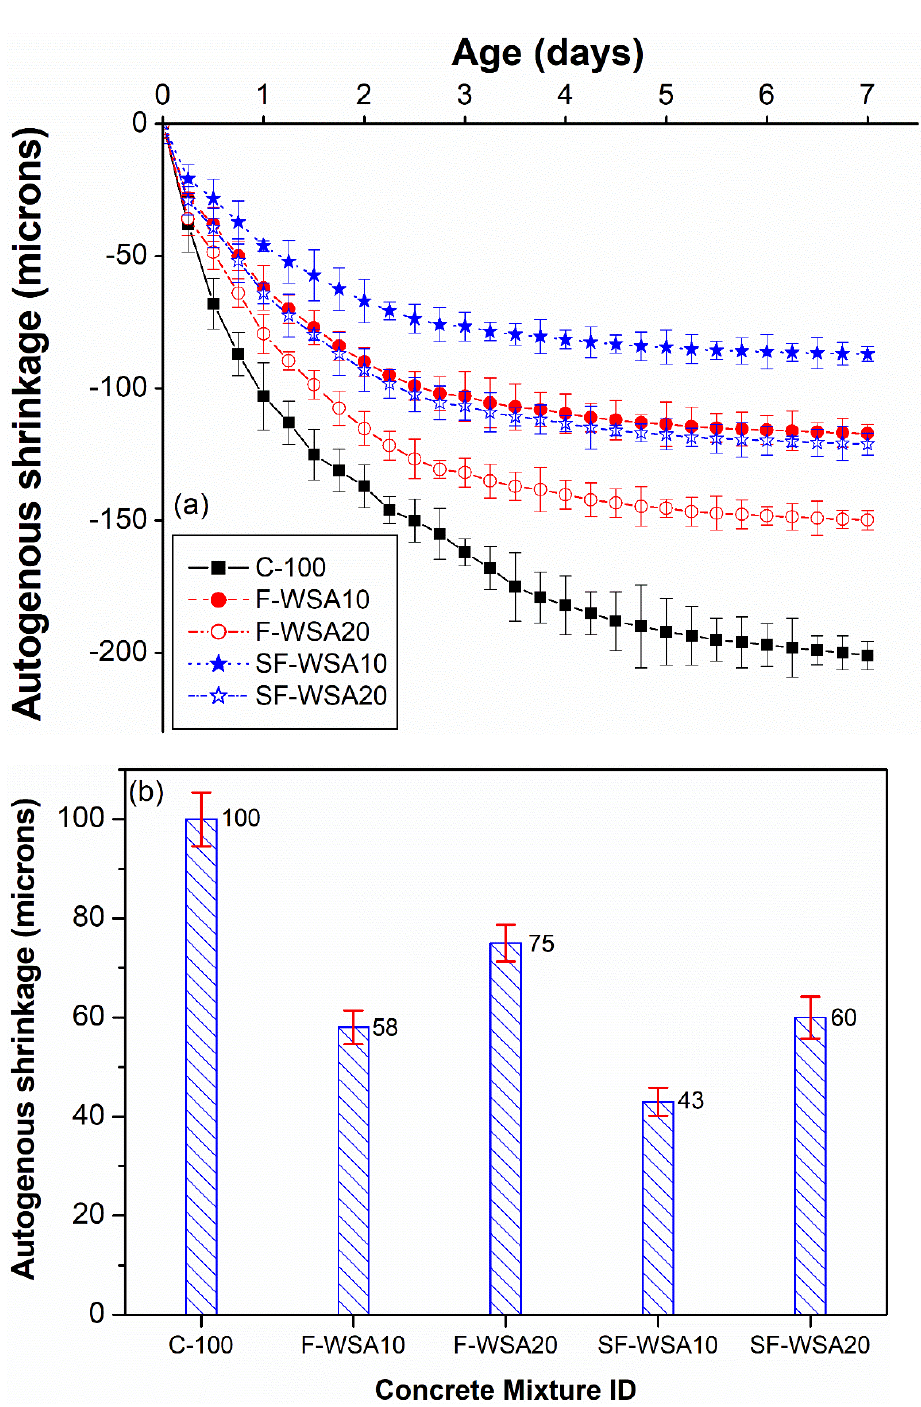
Figure 8. ( a ) Comparison of autogenous shrinkage of CC and binary concrete mixture containing 10% and 20% F-WSA and SF-WSA: ( b ) Normalized autogenous shrinkage of WSA concretes as a percentage of